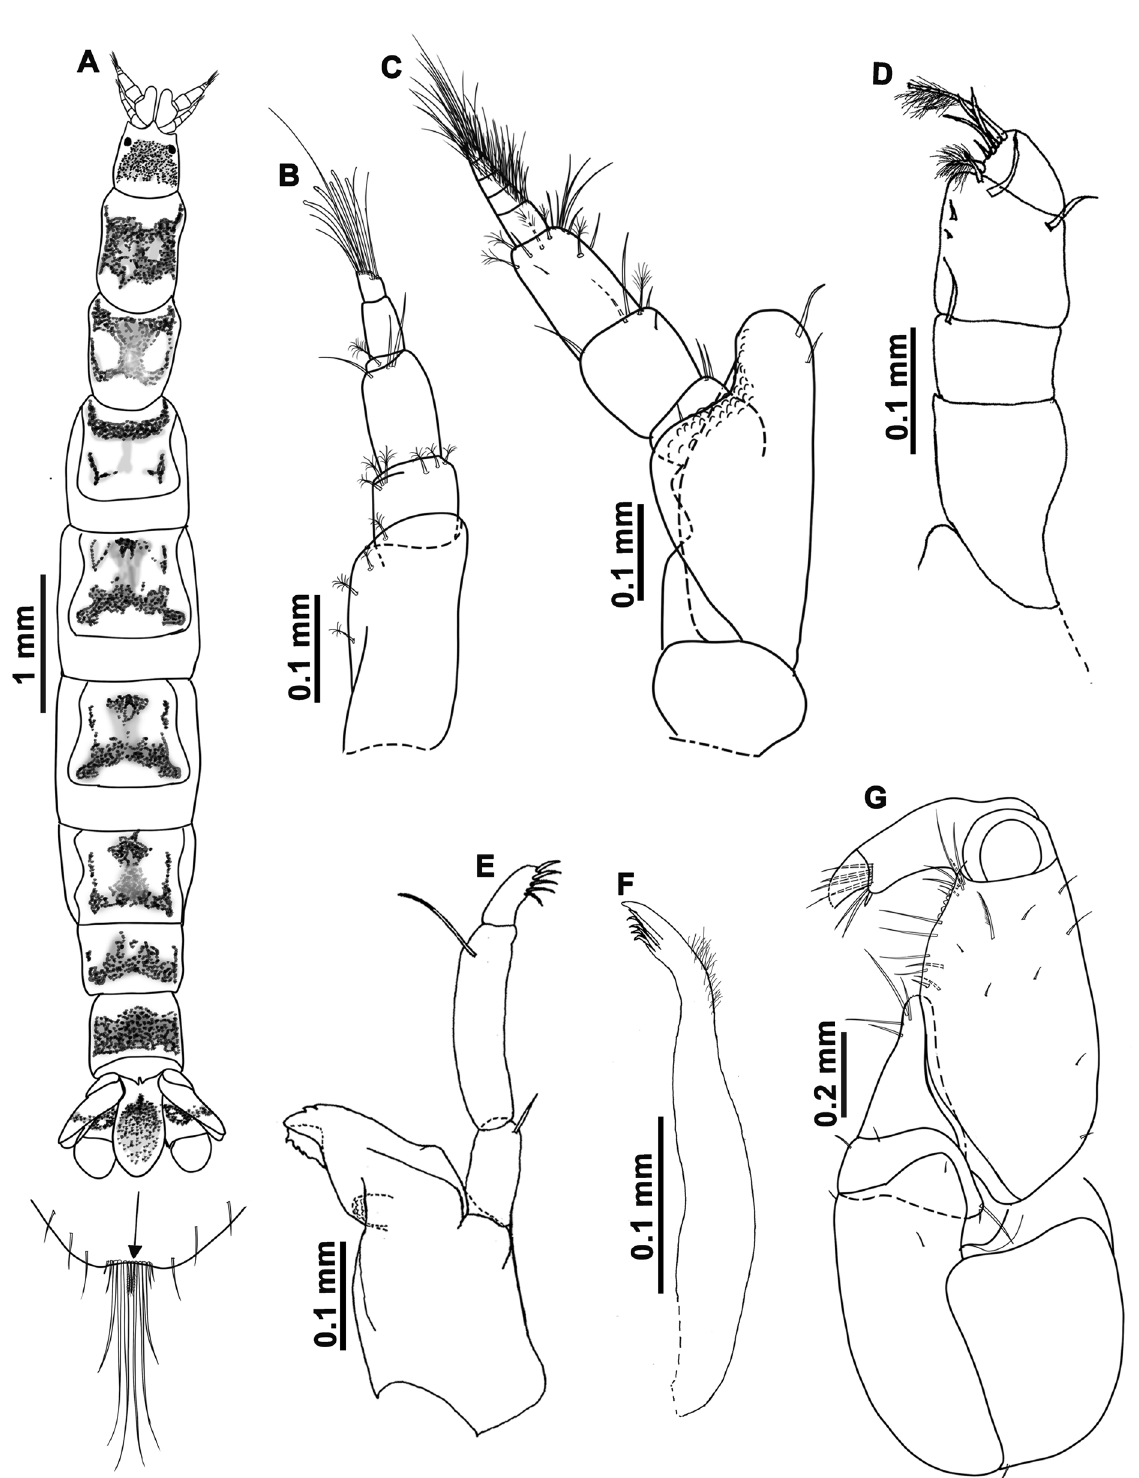
Fig. 8. Mesanthura antenniformis sp. nov., holotype, ♀ (ovigerous), 8 mm, Oaxaca, Puerto Ángel, Estacahuite Beach (UMAR-PERA 542). A . Habitus and detail of the telson. B . Antennule. C . Antenna (right). D . Maxilliped. E . Mandible. F . Maxilla. G . Pereopod